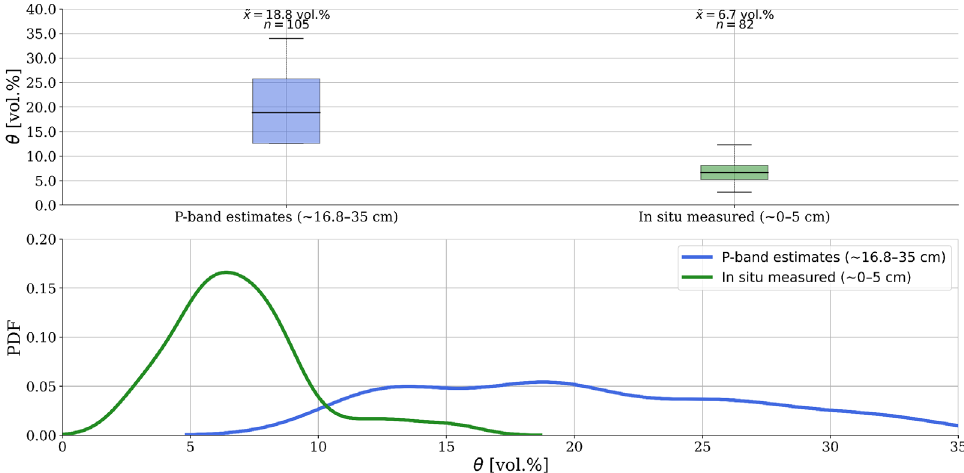
Figure 10. Comparison of retrieved soil moisture values, estimated with the proposed P-band SAR method and converted from permittivity according to the dielectric mixing model from [71], with in situ measured soil moisture values from various networks (cf. Section 2) at the AirMOSS monitoring site Walnut Gulch, AZ. (cid:101) x represents the respective median value, n is the total amount of values per